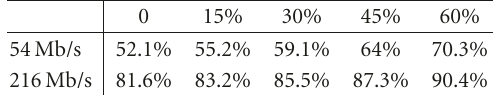
Table 1: Polling overhead versus percentage of idle stations.